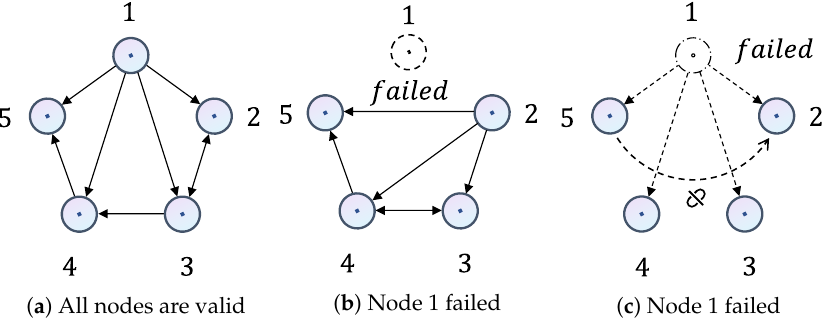
Figure 4. Schematic diagram of topology network with five nodes: ( a , b ) the adaptive topology networks and ( c ) the traditional leader-follower